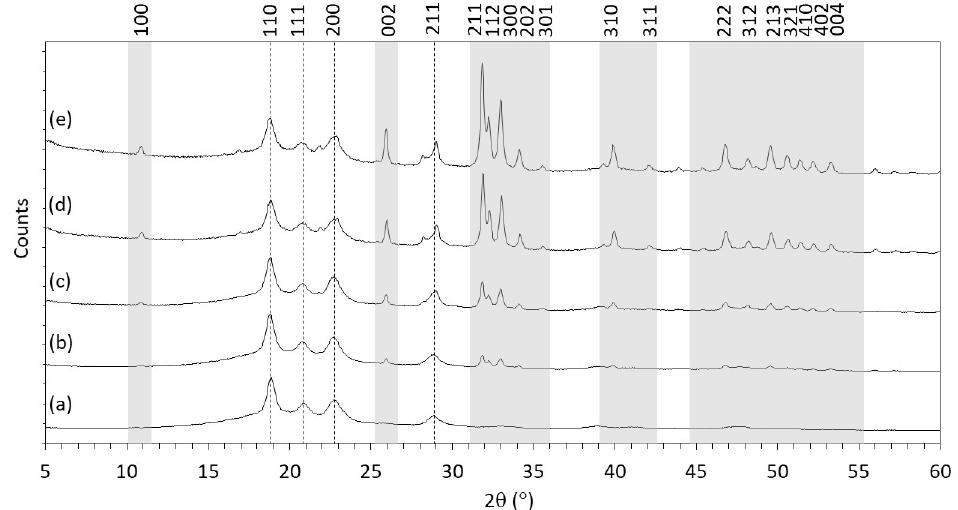
Figure 3. XRD patterns for ( a ) 0HA, ( b ) 5HA, ( c ) 10HA, ( d ) 20HA, and ( e ) 30HA. The main peaks for PEEK are given by dashed lines, the main peaks for HA are illustrated in the shaded areas. Miller indices for each peak are highlighted at the top of the figure.